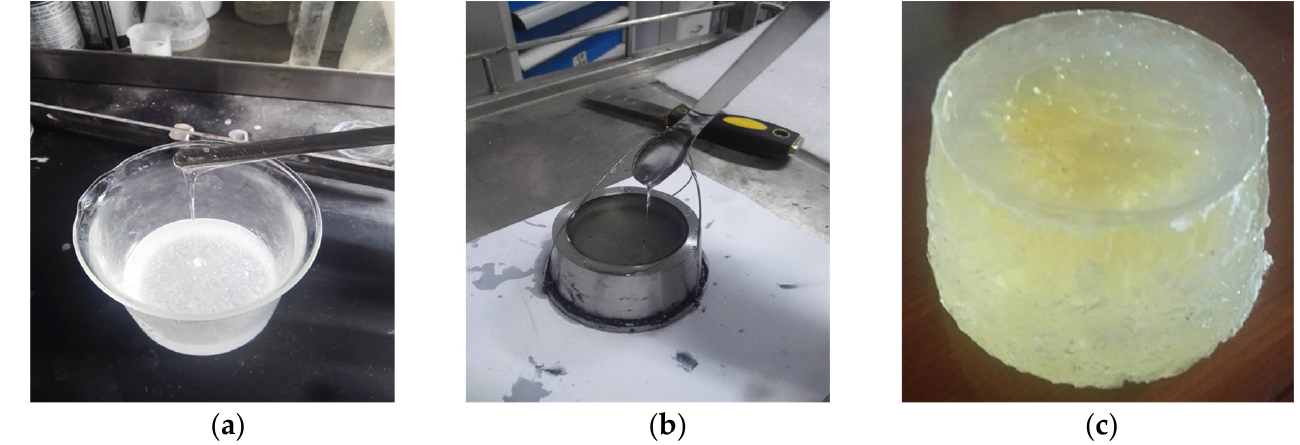
Figure 2. The experimental procedure of the sealant curing maintenance. ( a ) Formulation of epoxy- based polymers. ( b ) Curing state of the sealant. ( c ) Release of the sealant .